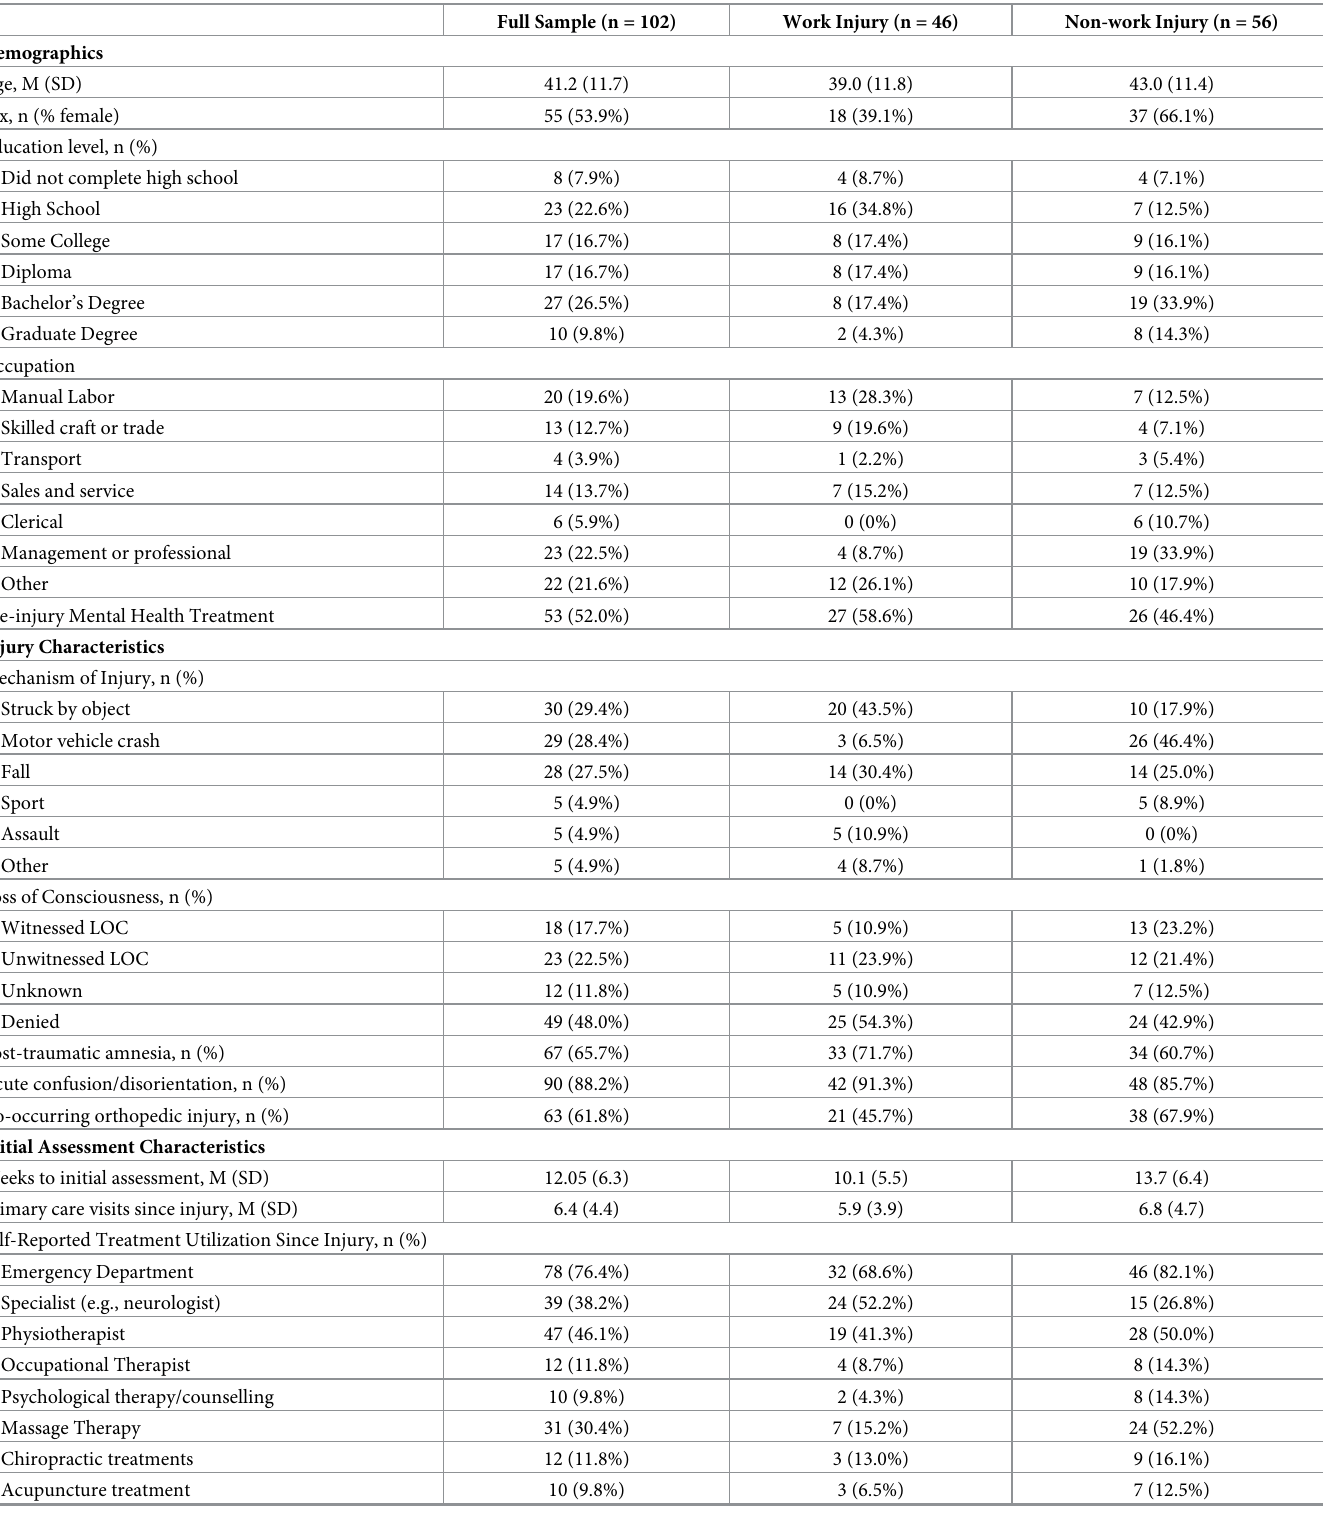
Table 1. Demographic, injury, and initial assessment